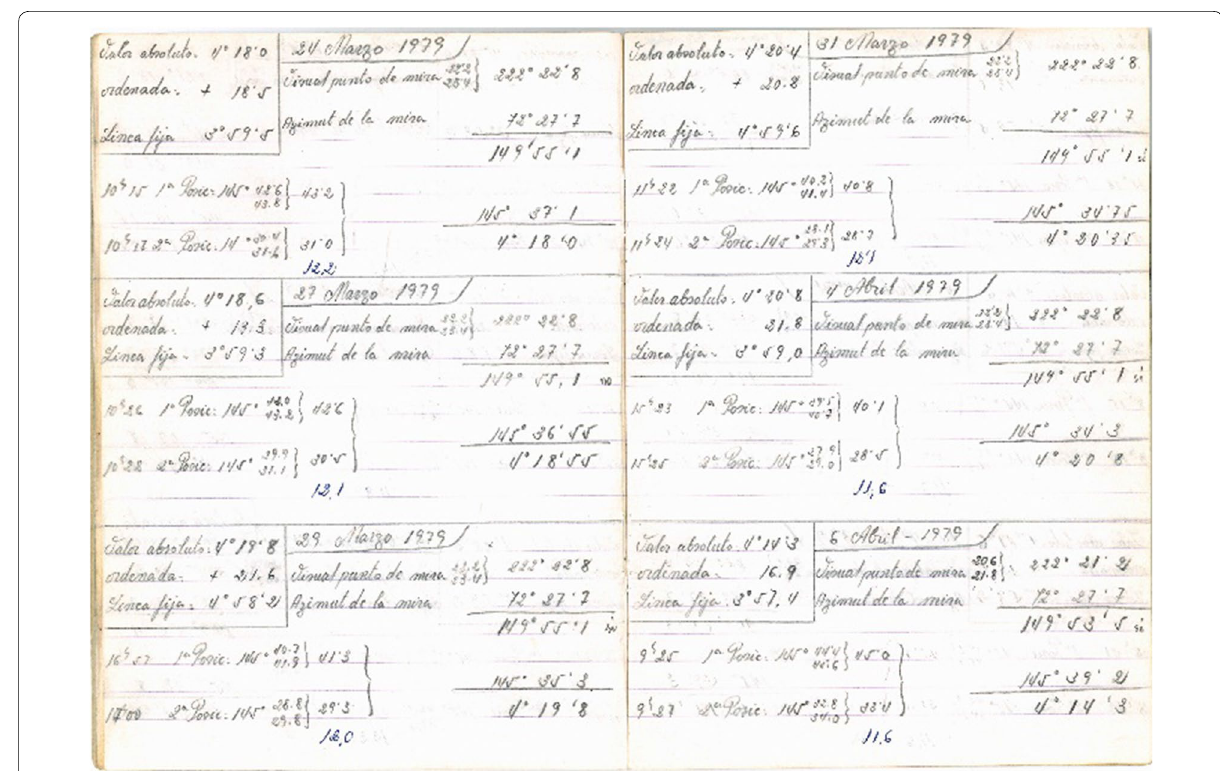
Fig. 4 Copy of a fragment of a notebook with annotated measures from the declinometer at Ebro